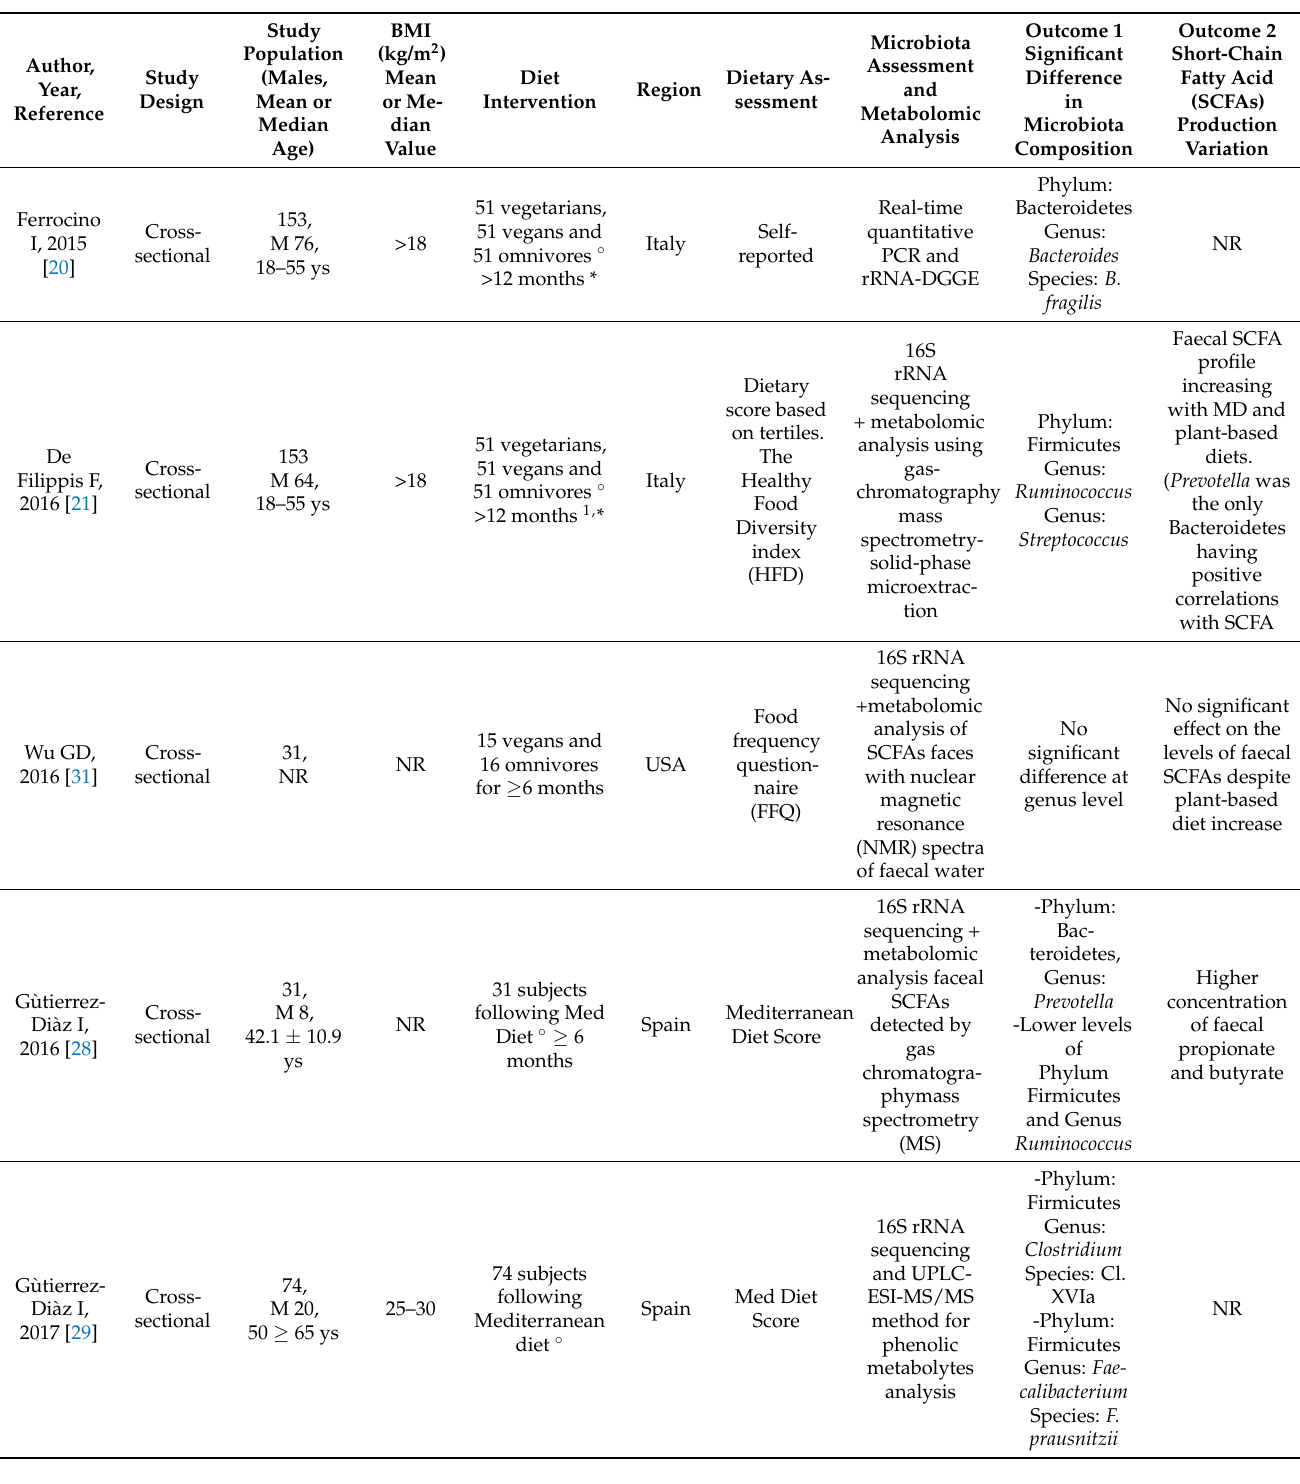
Table 1. Summary outline of the studies included in the systematic